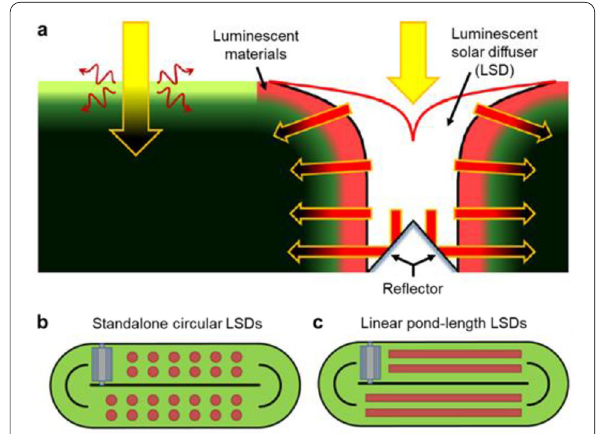
Fig. 11 a Cross-section schematic of a luminescent solar diffuser (LSD) to mitigate low penetration of incident light in open ponds for microalgae cultures. b , c Two ways of LSDs used in open ponds: standalone circular devices ( b ) or a linear array ( c ). Reproduced with permission from